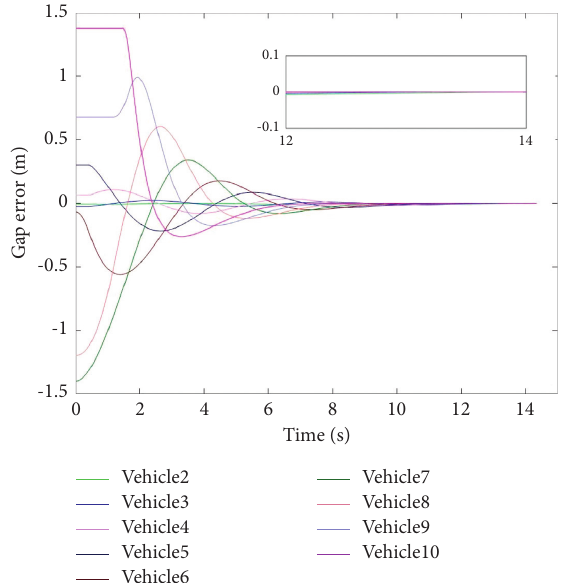
Figure 4: Gap error history under proposed controller